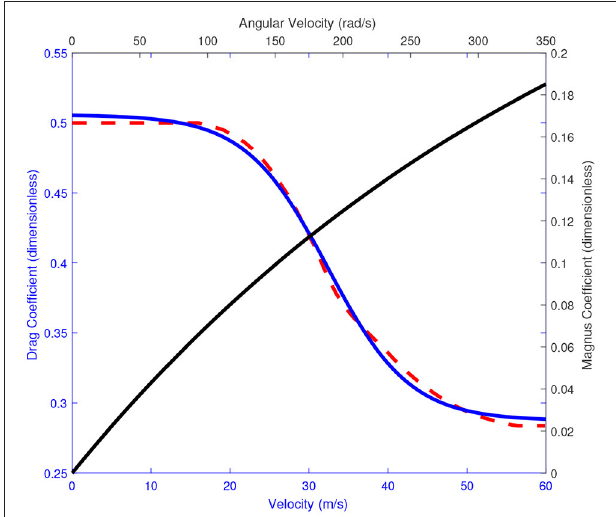
FIGURE 2 | Model of drag and Magnus coefficients. Adair’s drag model [7] and the approximation of Aguirre-López et al. [ 5] showing the sigmoidal decreasing of drag when increasing the velocity of the ball. In turn, the Magnus model (10) presented in Robinson [8] shows that the Magnus coefficient increases when the angular velocity increases. Modified from Aguirre-López et al.